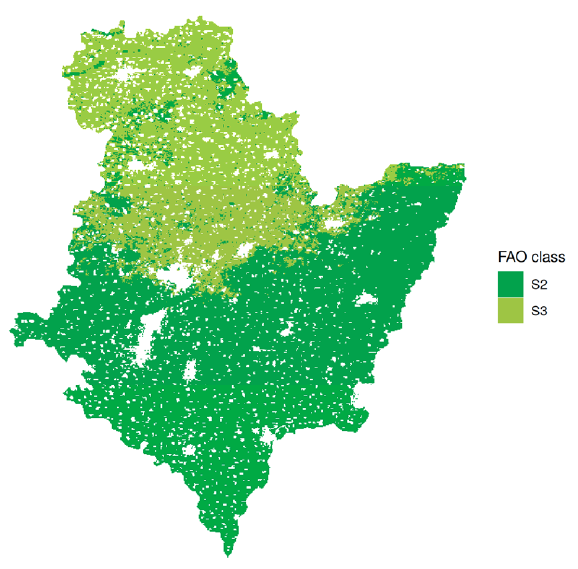
Figure 12. LS classes for maize in Hengshui .